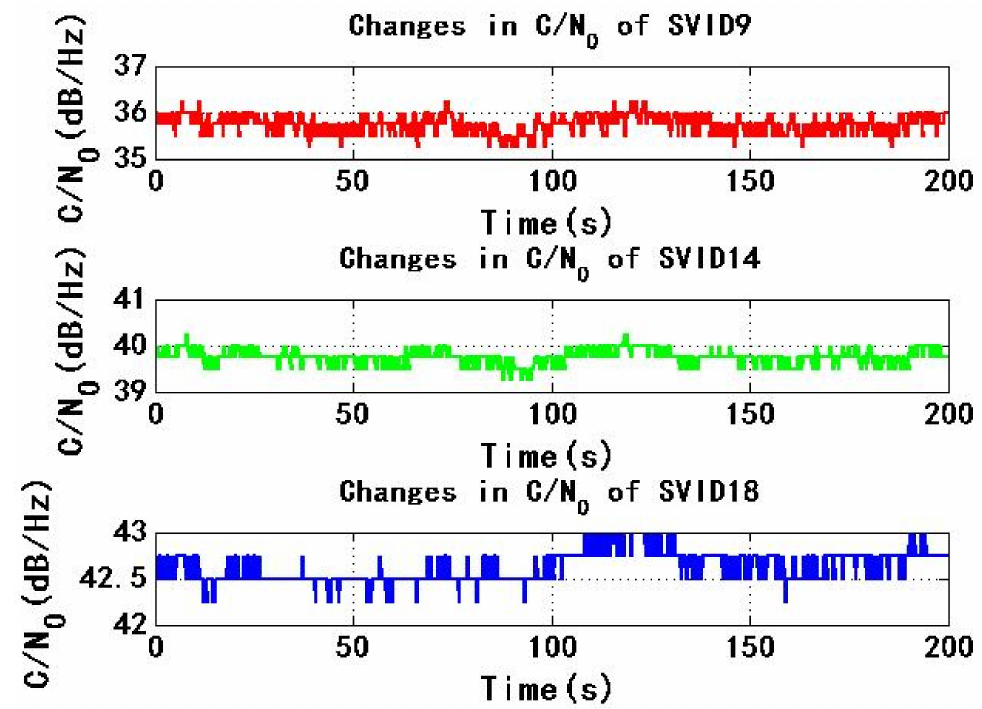
Figure 15. Changes in C / N 0 of SVID9, 14, 18 in experiment